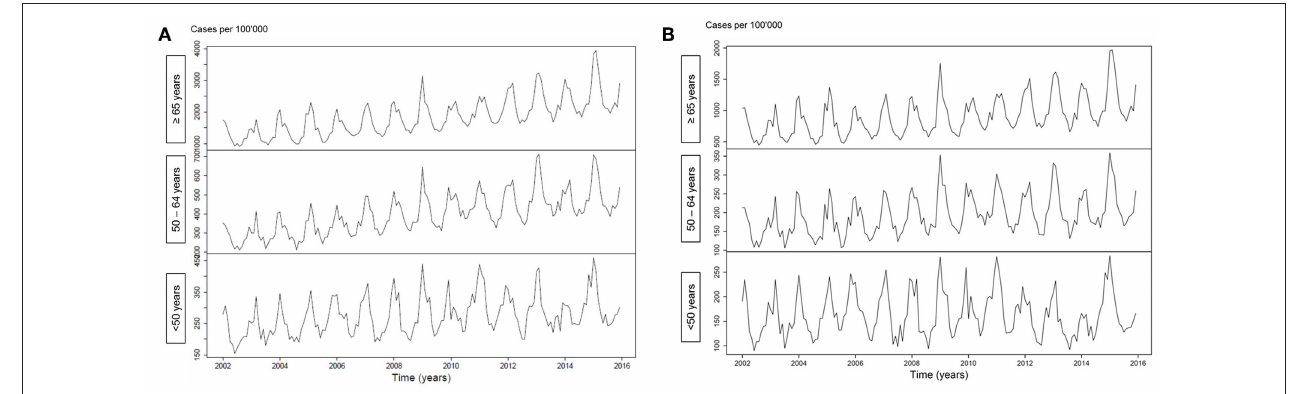
FIGURE 1 | (A) Incidence of pneumonia hospitalization (any diagnosis) over time, stratified for age groups. (B) Incidence of pneumonia hospitalization (primary diagnosis) over time, stratified for age groups.